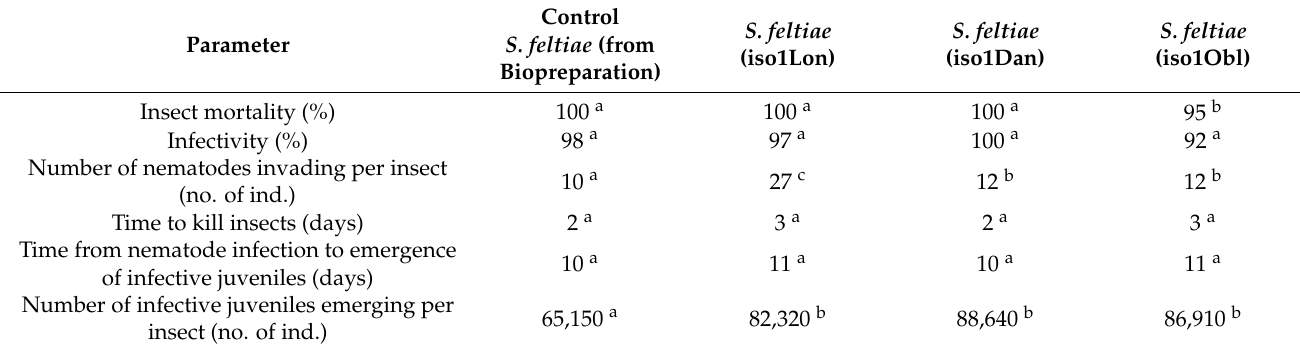
Table 3. Biological activity of Steinernema feltiae isolates (mean values).